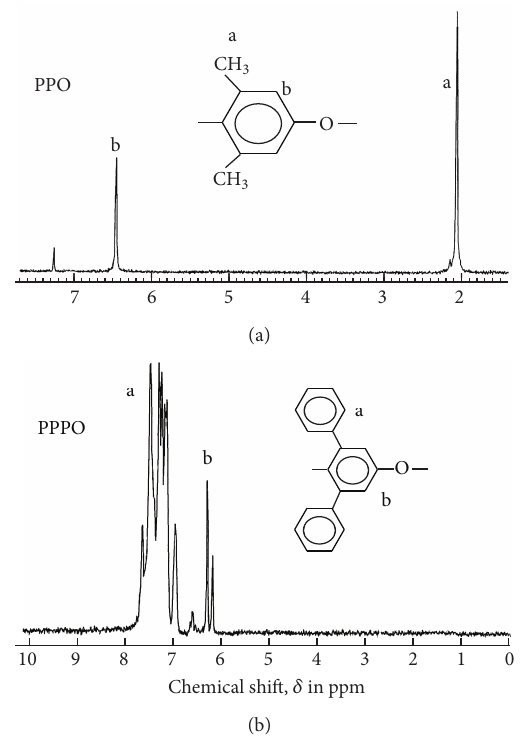
100 mL round bottom �ask at room temperature. en, 0.5 gm (4.3 mmol) of TMEDA and 0.03 gm (0.27 mmol)